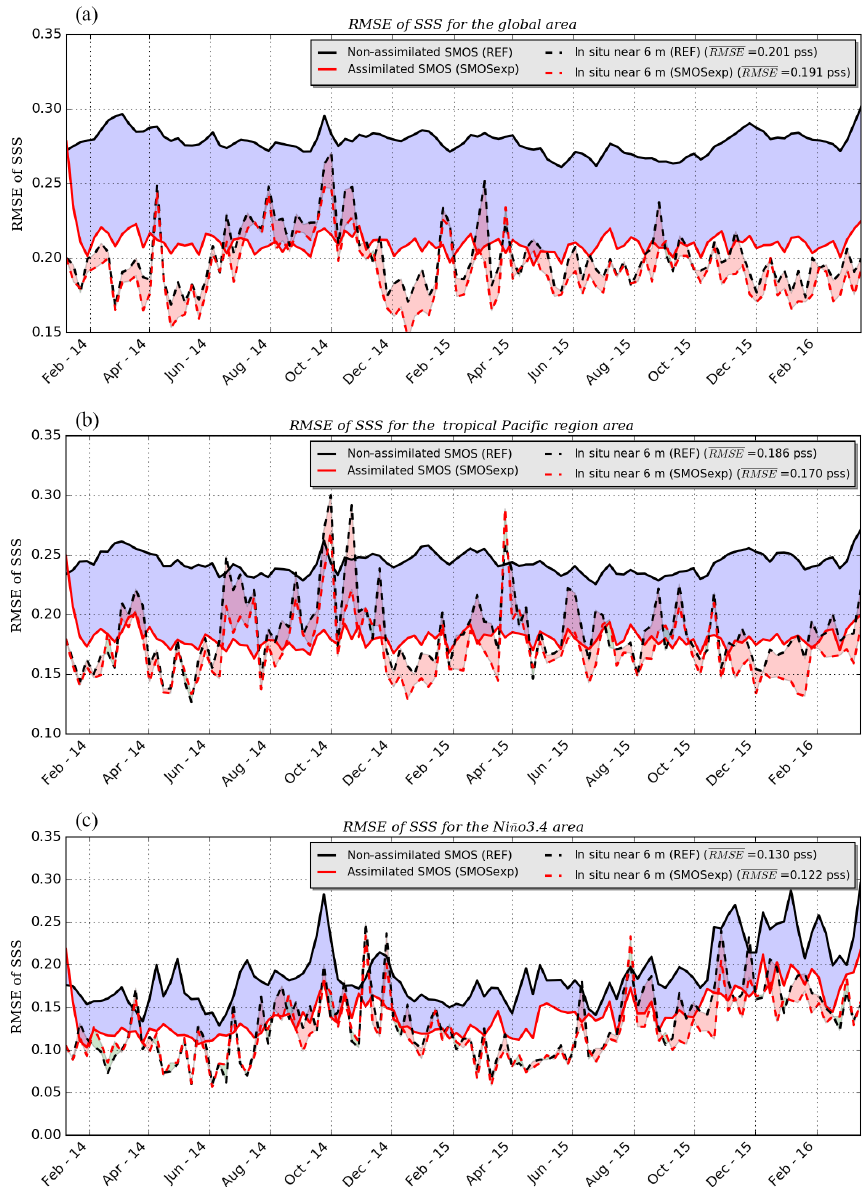
Figure 6. RMSE of SSS with respect to SMOS data (solid lines) and RMSE of salinity near 6m depth with respect to in situ salinity data (dashed lines) in the 1–6-day forecast fields in REF (black lines) and SMOSexp (red line) in the global domain (a) , the tropical Pacific (b) and in the Niño3.4 region (c) . RMSEs are evaluated for each week, and the mean RMSE of the in situ salinity is denoted in the legend. The regions used here have southwest and northeast corners defined as follows: tropical Pacific – 30 ◦ S, 120 ◦ E to 30 ◦ N, 70 ◦ W; Niño3.4 – 5 ◦ S, 170 ◦ W to 5 ◦ N, 120 ◦